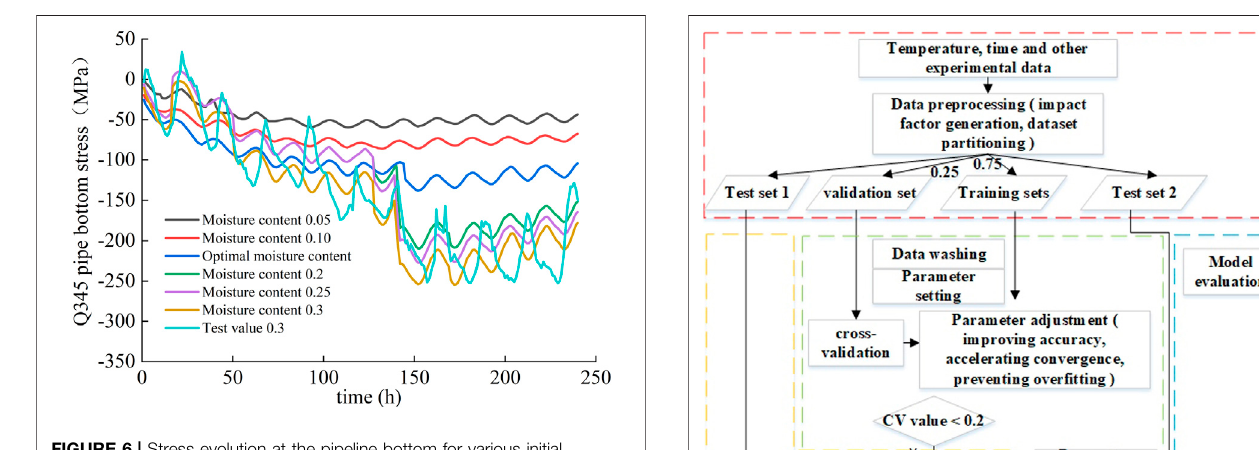
FIGURE 6 | Stress evolution at the pipeline bottom for various initial moisture